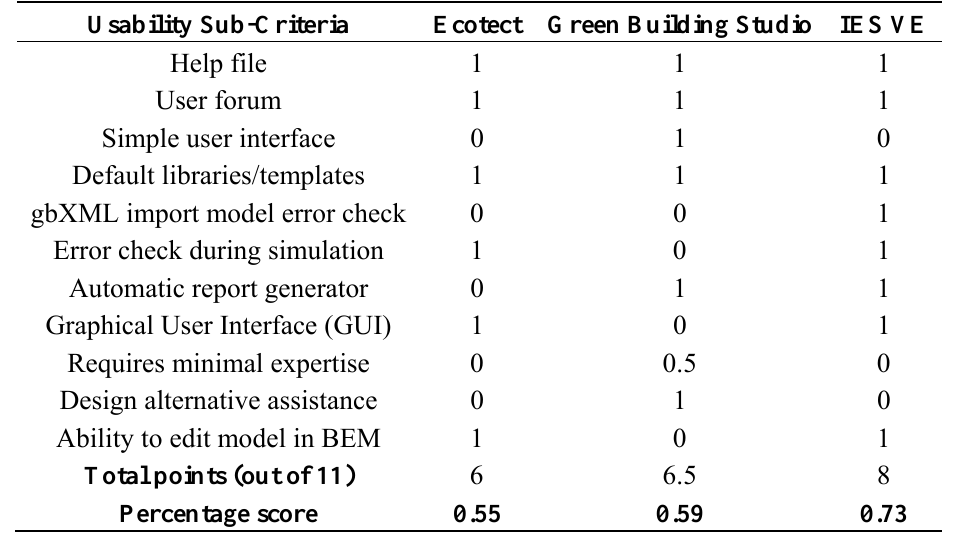
Table A8. Re-evaluation: usability criterion calculations for the top three BEM tools.